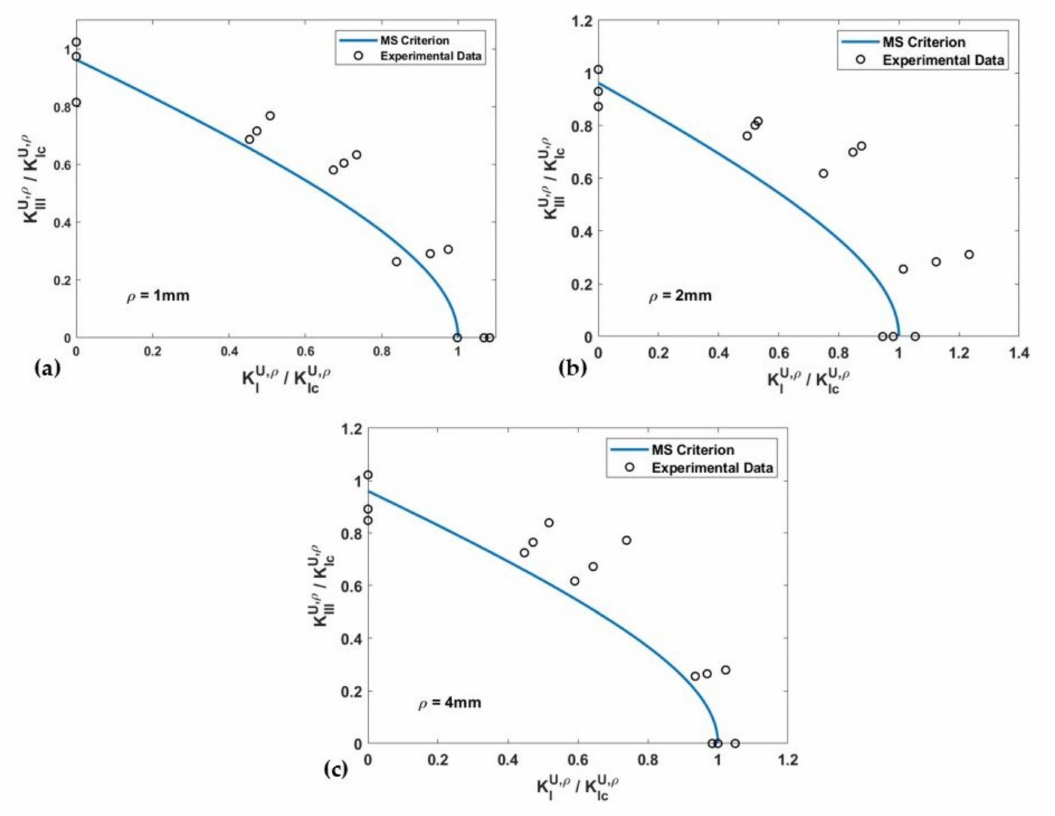
Figure 9. Fracture limit curves of the MS criterion and the experimental data of U-notched spruce